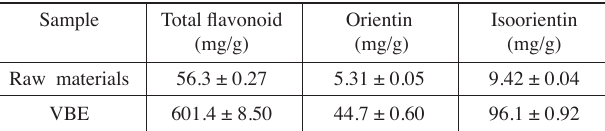
Tab. 2: The content between the raw materials and the extracts. (Mean ± SD, n =